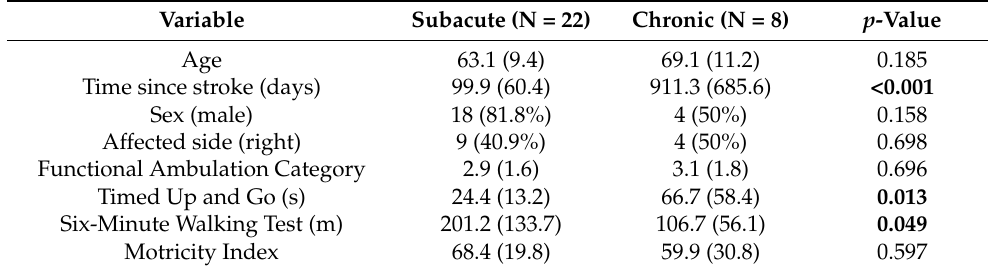
Table 1. Demographic and clinical characteristics of the sample. p values refer to the Mann–Whitney U test, or Fisher’s exact test, as appropriate. Values in bold indicate a statistically significant difference between subacute and chronic stroke patients ( p < 0.05).